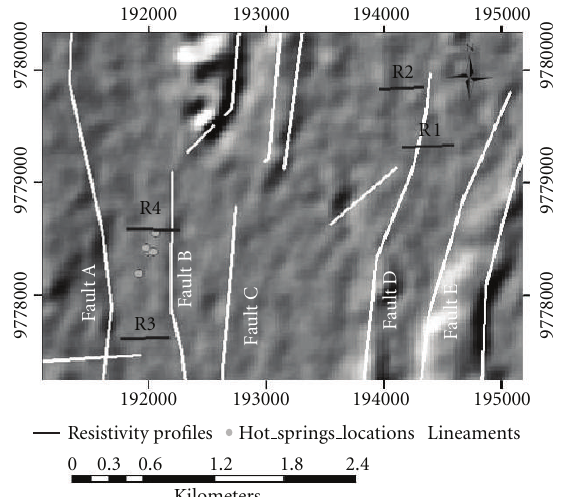
Figure 5: Hill-shaded ASTER DEM showing the locations of resistivity profiles (R1, R2, R3, and R4) in the study area.